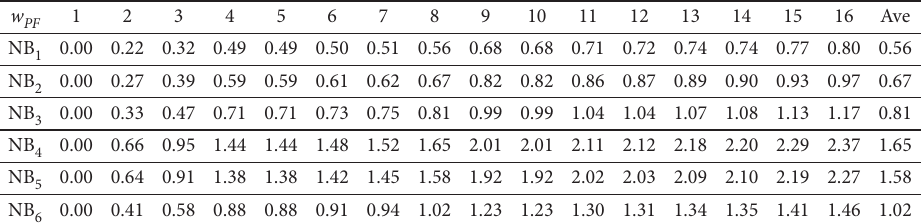
with FS-OWAIMAM I operator PF